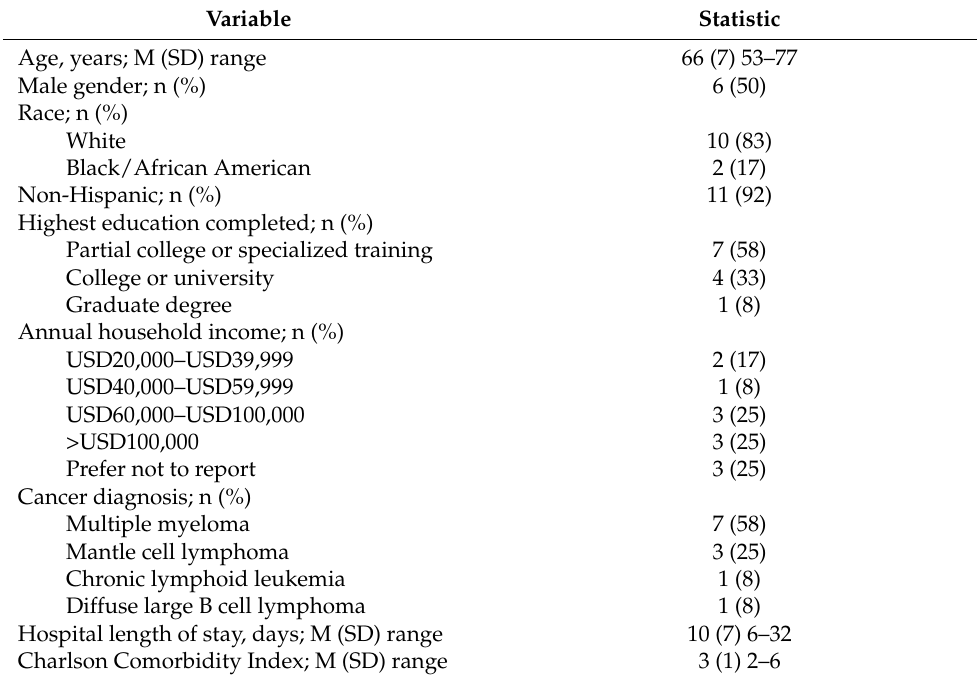
Table 2. Participants’ demographic and clinical characteristics (N =